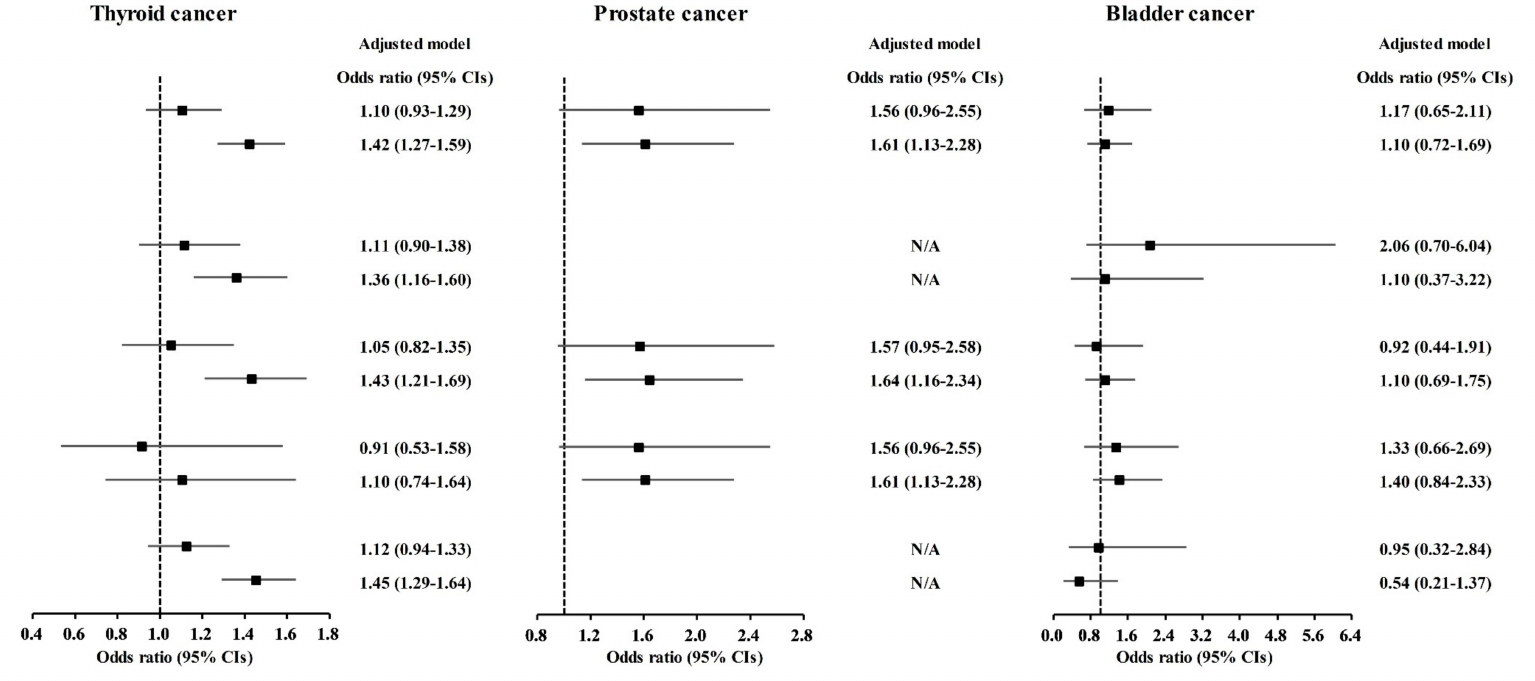
Figure 7. Odds ratios of physical exercise for thyroid cancer, prostate cancer, and bladder cancer histories according to age and